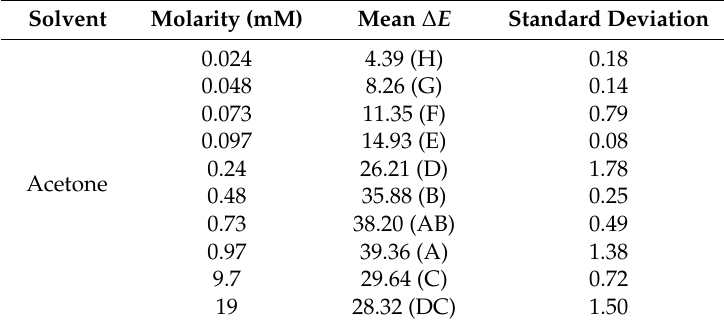
Table 3. Mean ∆ E of the molarities when dissolved in acetone. Different letters classify the data as statistically different within each molarity. DF =